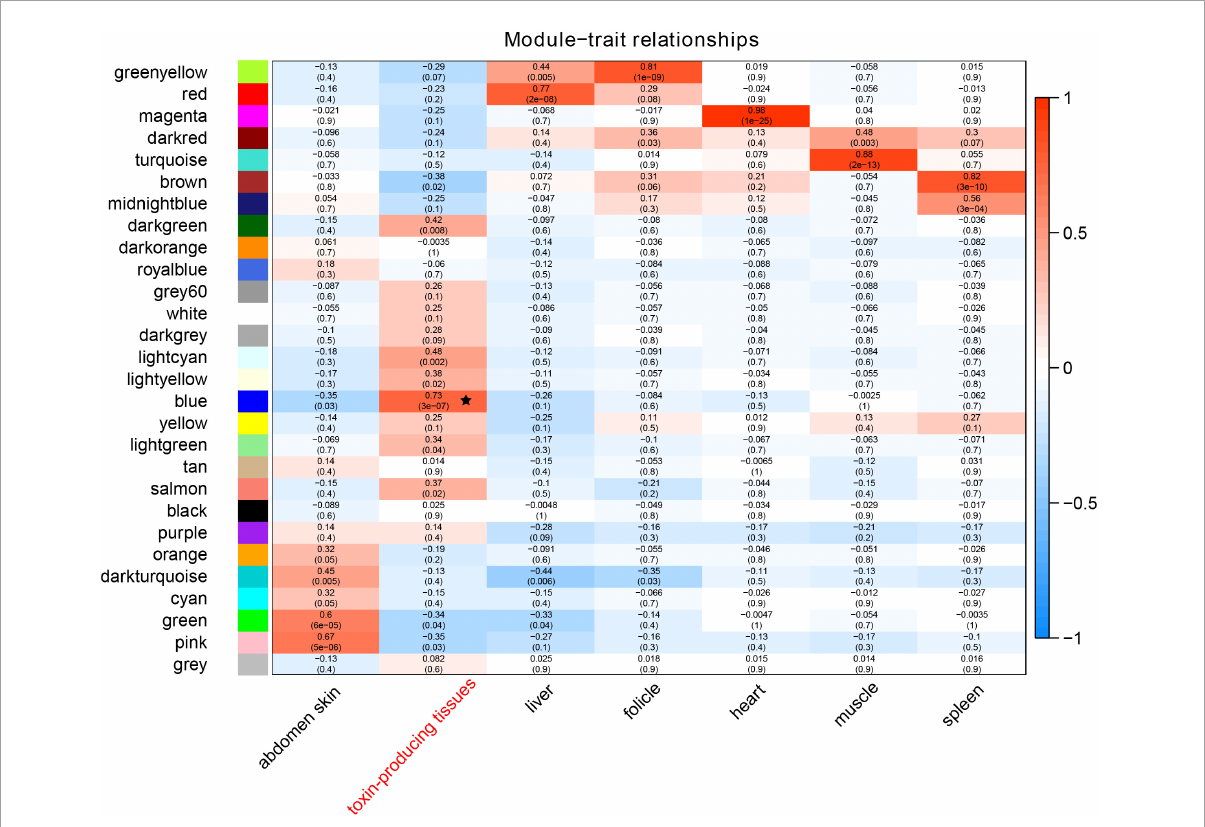
FIGURE1 A heatmap of correlations between modules and traits. The colored shades represent correlations, and the numbers in parentheses illustrate p values. The black star represents the most correlated module (in blue).